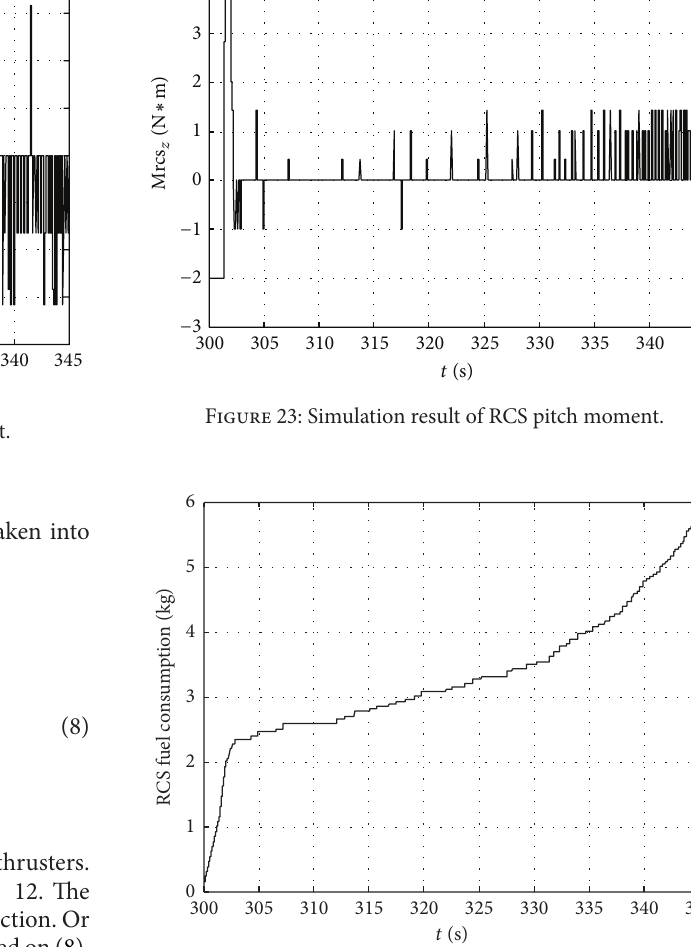
Figure 24: Simulation result of RCS